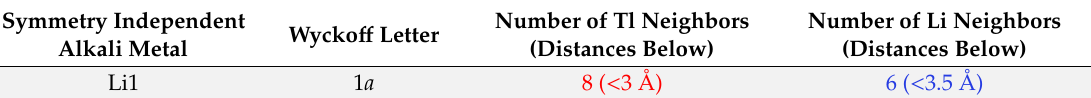
Table 8. Surrounding atoms of the symmetry inequivalent alkali metal position in LiTl (space group Pm -3 m ). The color-coding refers to the color of the contacts in Figure 9.